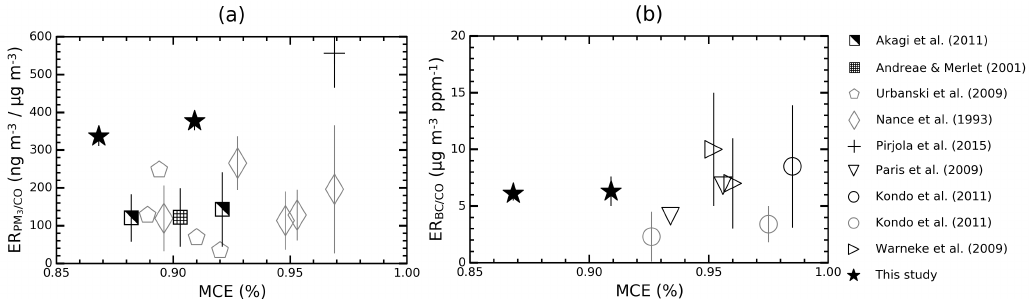
Figure 8. Scatter plots of particle ER Y /X with standard uncertainties (where available) versus MCE for this study and previous publications.